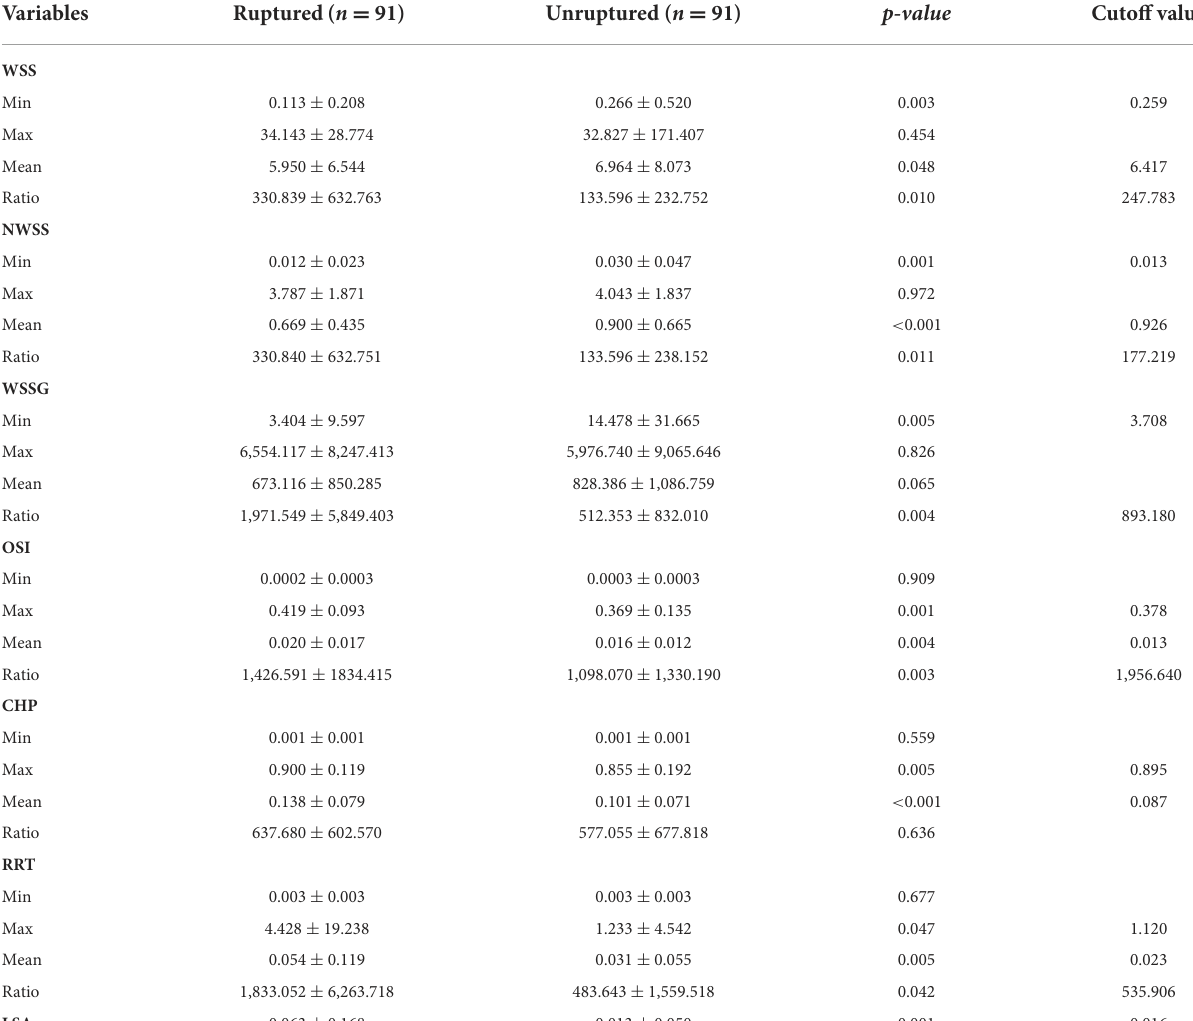
TABLE 2 Measurement and analysis of the hemodynamics.